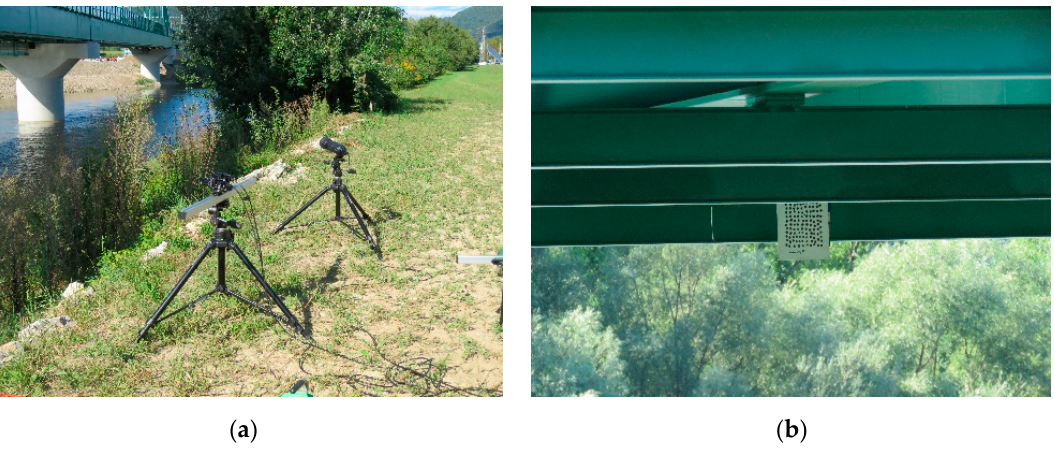
Figure 22. Photogrammetric digital image correlation equipment: ( a ) Two active cameras applied during the experiment as part of the 2D-DIC system. ( b ) The steel boards painted by white color and by a black random pattern fixed at the observed point on the bridge deck.